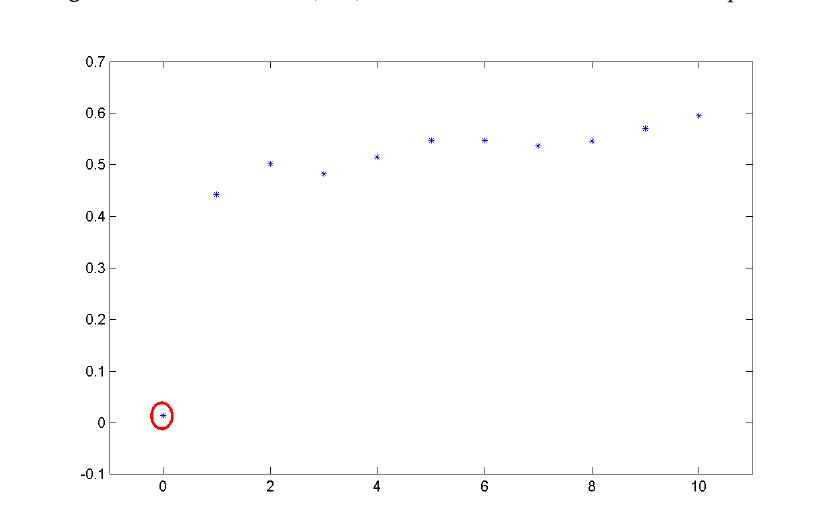
Figure 1. Debt-To-Income (DTI) feature transformed with the cubic spline.